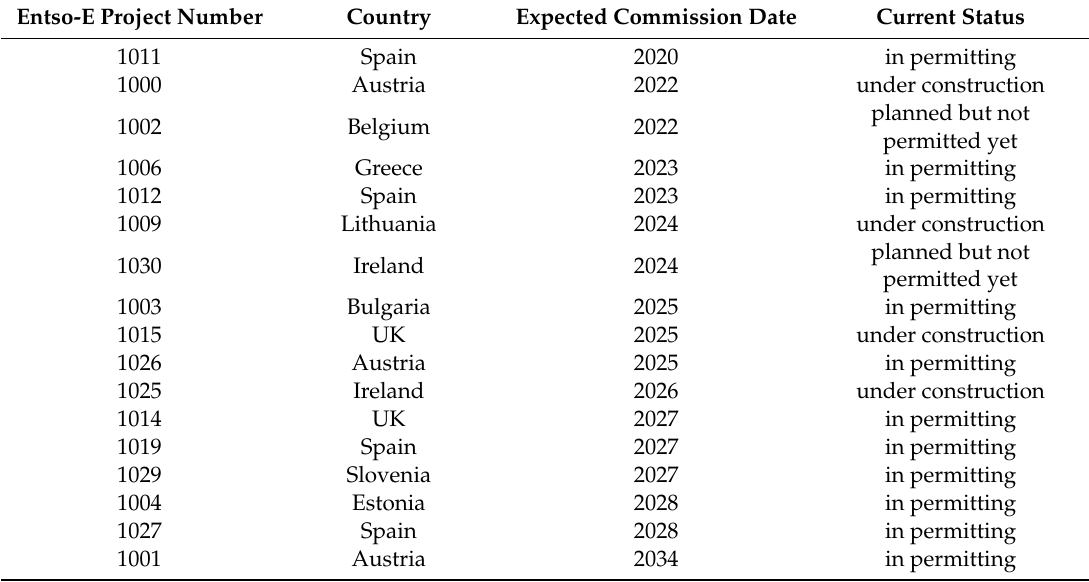
Table 2. New pumped hydro storage (PHS) storage projects in the EU based on